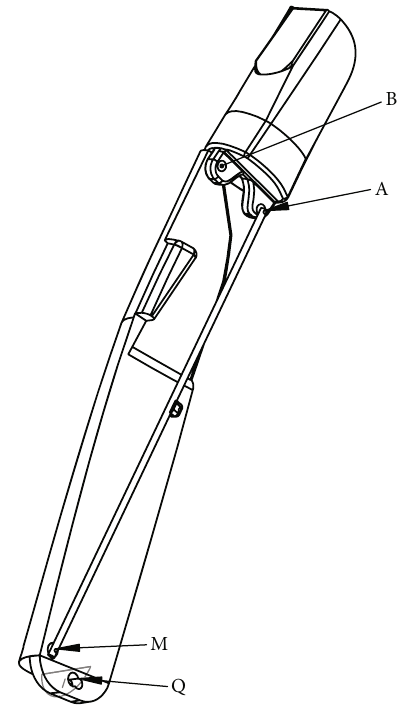
Figure 2: Structure of thumb fi nger mechanism without its